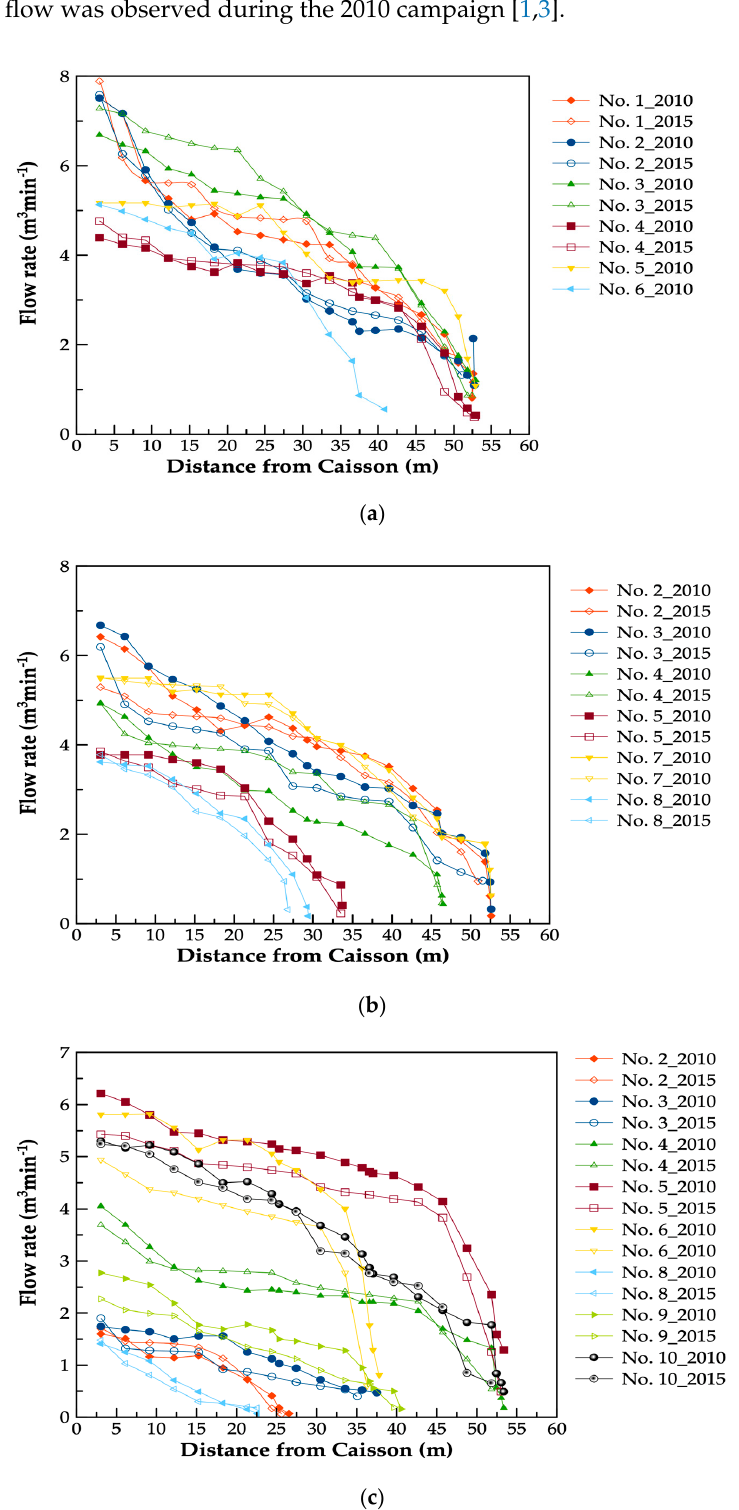
Figure 5. Flow versus distance at ( a ) Collector 3, ( b ) Collector 4, and ( c ) Collector 5. Average unit flow capacity of each lateral, which is also greater at the end of lateral flow, effects large gains in production within only a few meters. This is particularly noticeable in Laterals 3 and 4